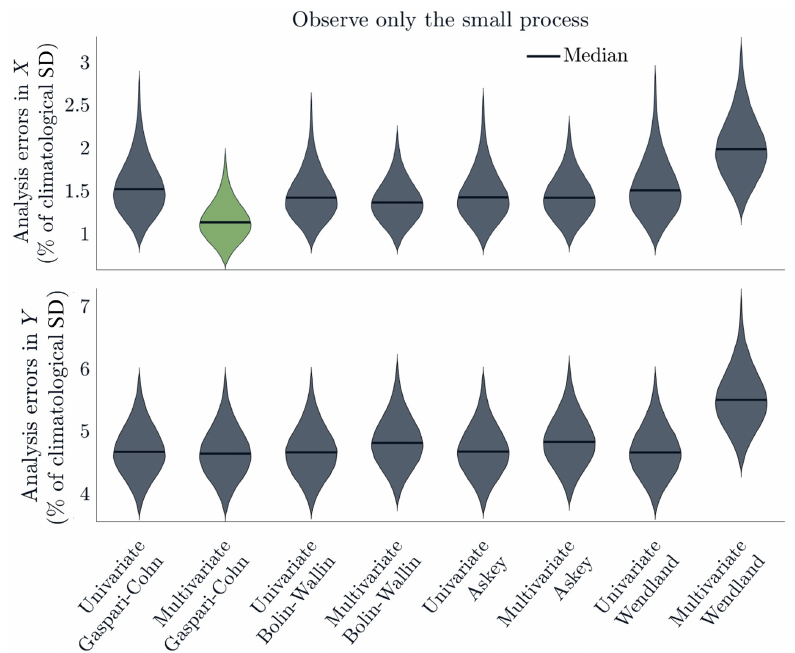
Figure 3. Violin plots show the distribution of analysis errors for the X and Y processes with different localization functions (Hoffmann, 2015). Analysis errors are calculated as RMS deviations from the truth and are scaled by the climatological standard deviation of the asso- ciated process. All four univariate localization functions perform similarly, while there is a greater range in performance for the multivariate versions of these functions. Multivariate Gaspari–Cohn shows improvement over its univariate counterparts. Univariate and multivariate Bolin–Wallin and Askey functions appear to perform similarly. For Wendland, the multivariate function performs significantly worse than the univariate